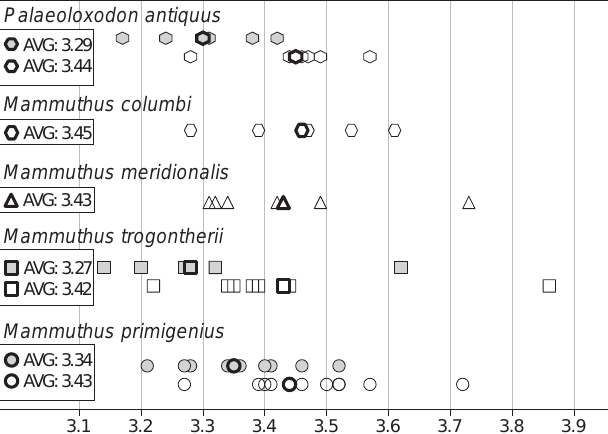
Fig. 2. Scapula lengths vs. skeletal shoulder height ratio of selected pro- boscideans based on the data collected in this study (Appendix 1, SOM: table 2; AL unpublished data). The ratios shaded in grey correspond to the maximal length of the scapula and the white ones to the articular length of the